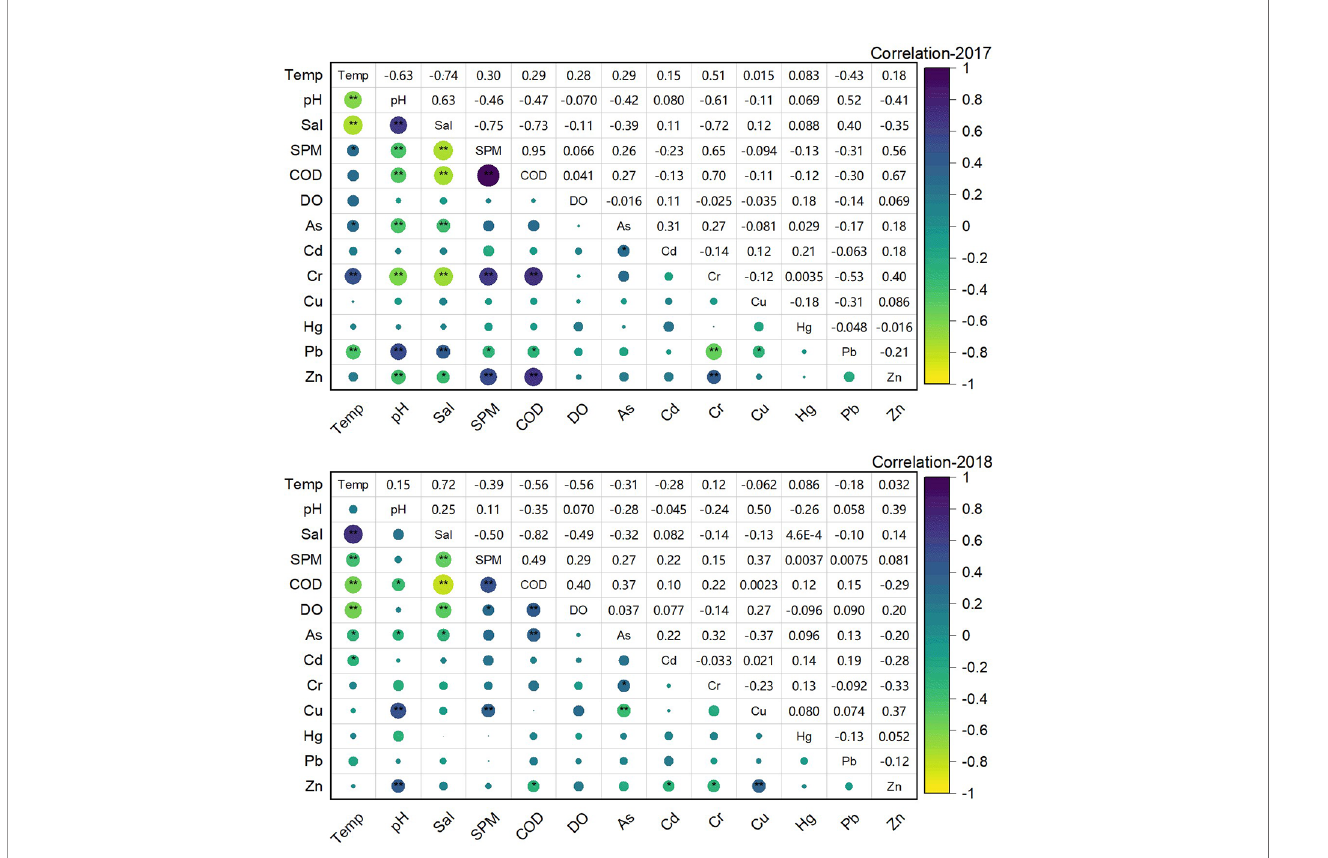
FIGURE 7 | The correlation analysis of heavy metals in the seawater of coastal Zhuhai in 2017 and 2018, respectively (*P < 0.05; **P